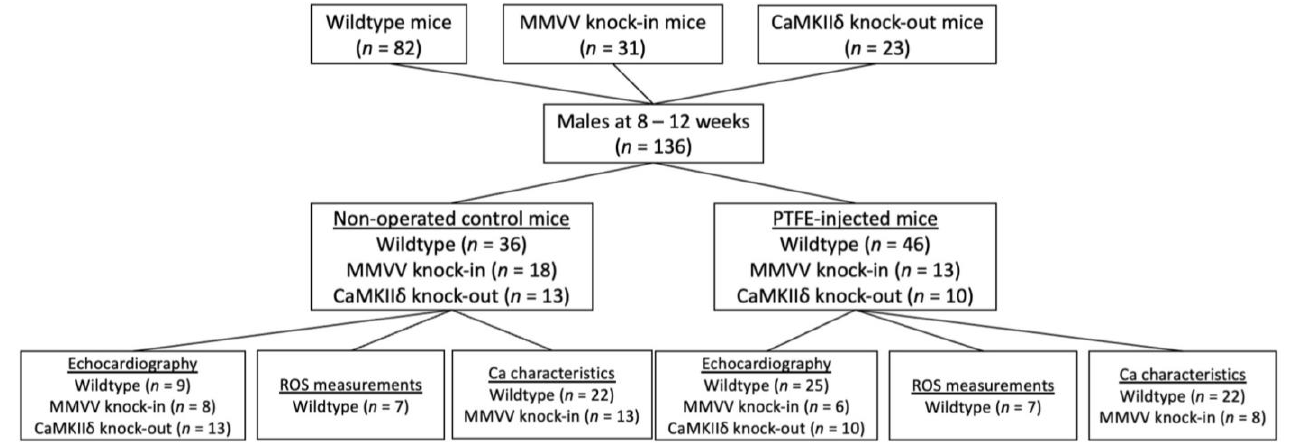
Figure 1. Study flowchart. C57BL/6 wildtype, MMVV knock-in, and CaMKII δ knock-out mice were randomly assigned to either control or OSA induction by PTFE injection. After 8 weeks, echocardiography, ROS measurements, and epifluorescence microscopy were performed, whereby some experiments were performed in the same subject.